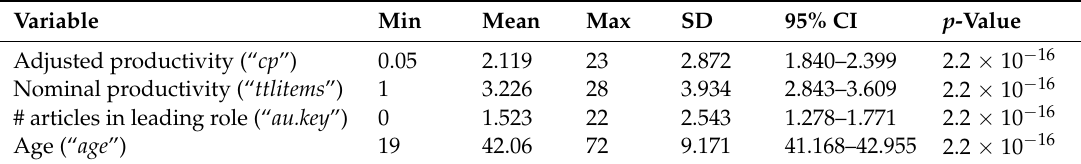
Table 2. Descriptive statistics for variables after the removal of the outlying data